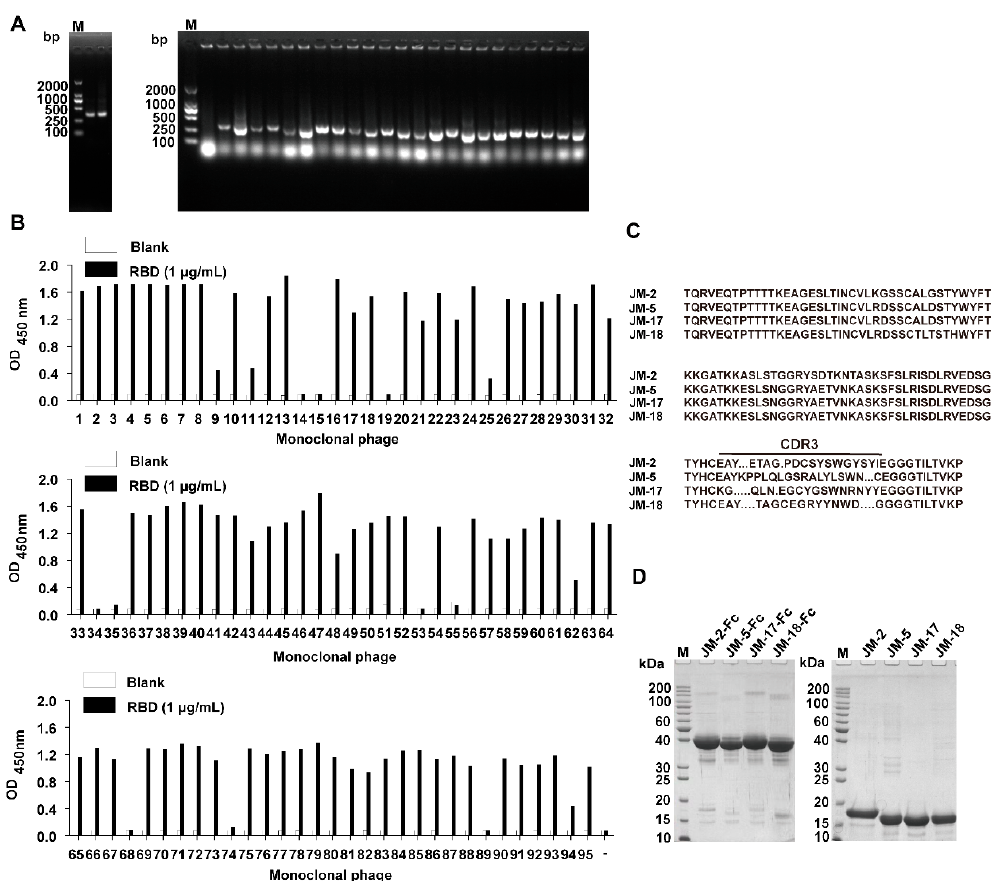
Figure 1. Isolation of anti-SARS-CoV-2 RBD VNARs from RBD-immunized C. plagiosum by